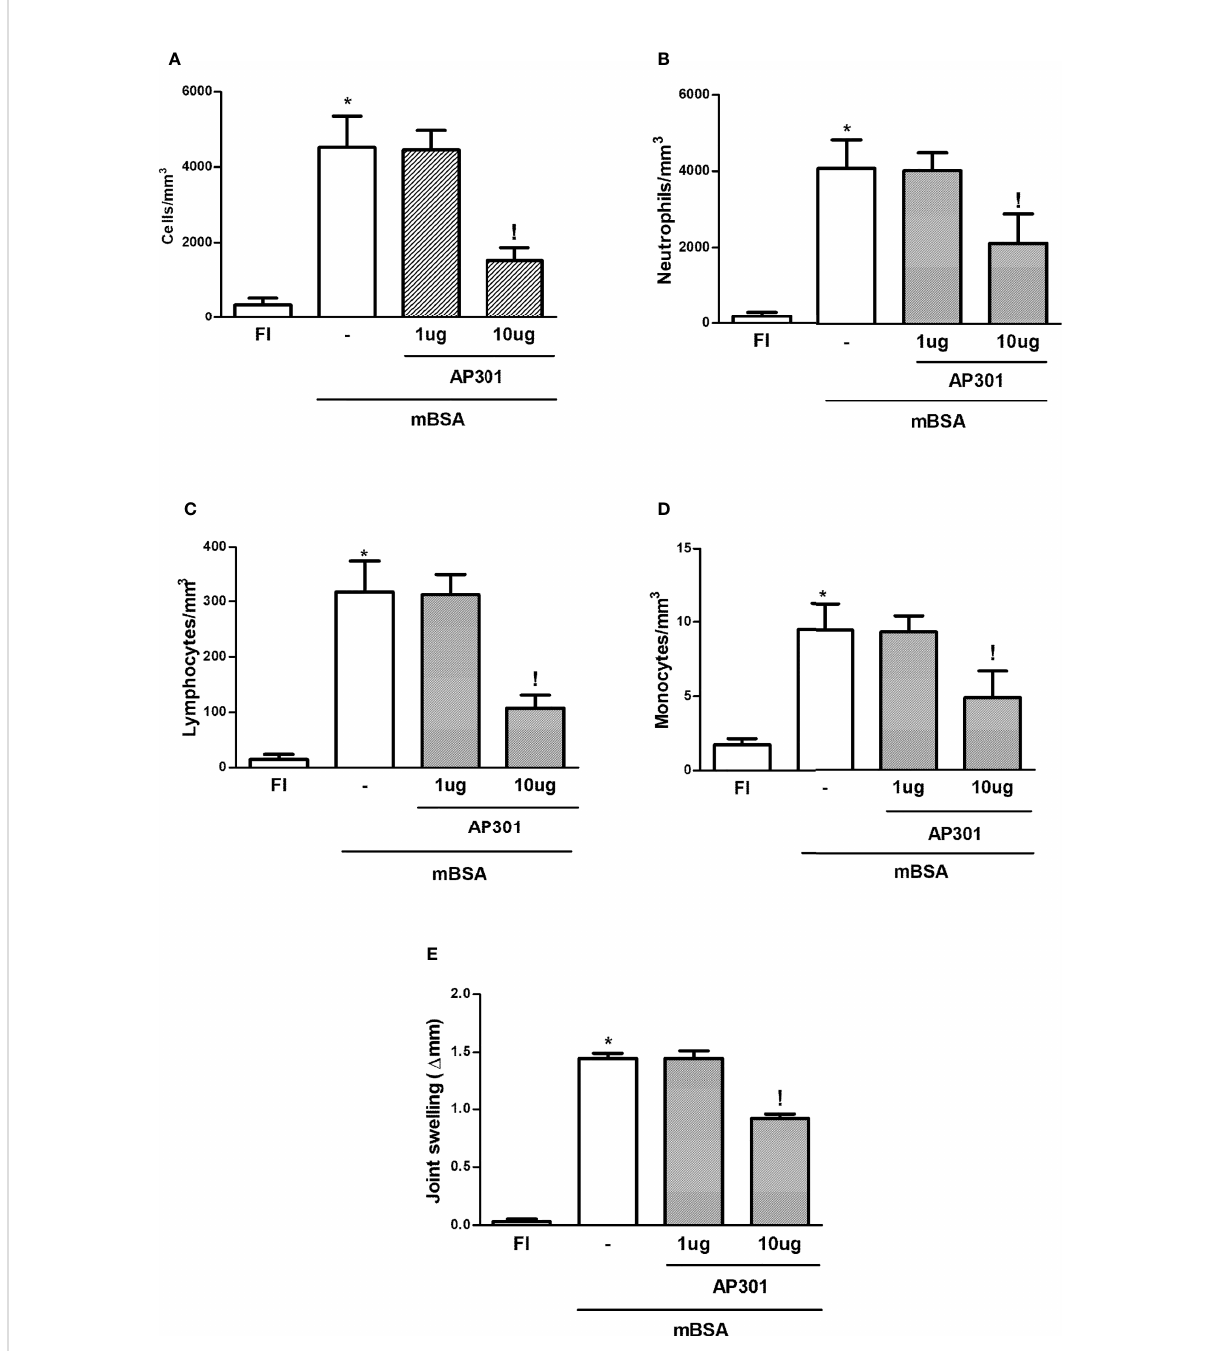
FIGURE 3 Mice subjected to mBSA arthritis received i.v. solnatide (AP 301) or saline ( − ) just prior to challenge with mBSA. Joint volume and cell counts were assessed with calipers or in joint washes, respectively. FI stands for control, false-immunized animals; *p<0.05 compared to FI;!p<0.05 compared to mBSA, using Student ’ s “ t ” test (n ≥ 3 animals/group). (A – D) Total and differential cell counts; (E) D paw volume relative to